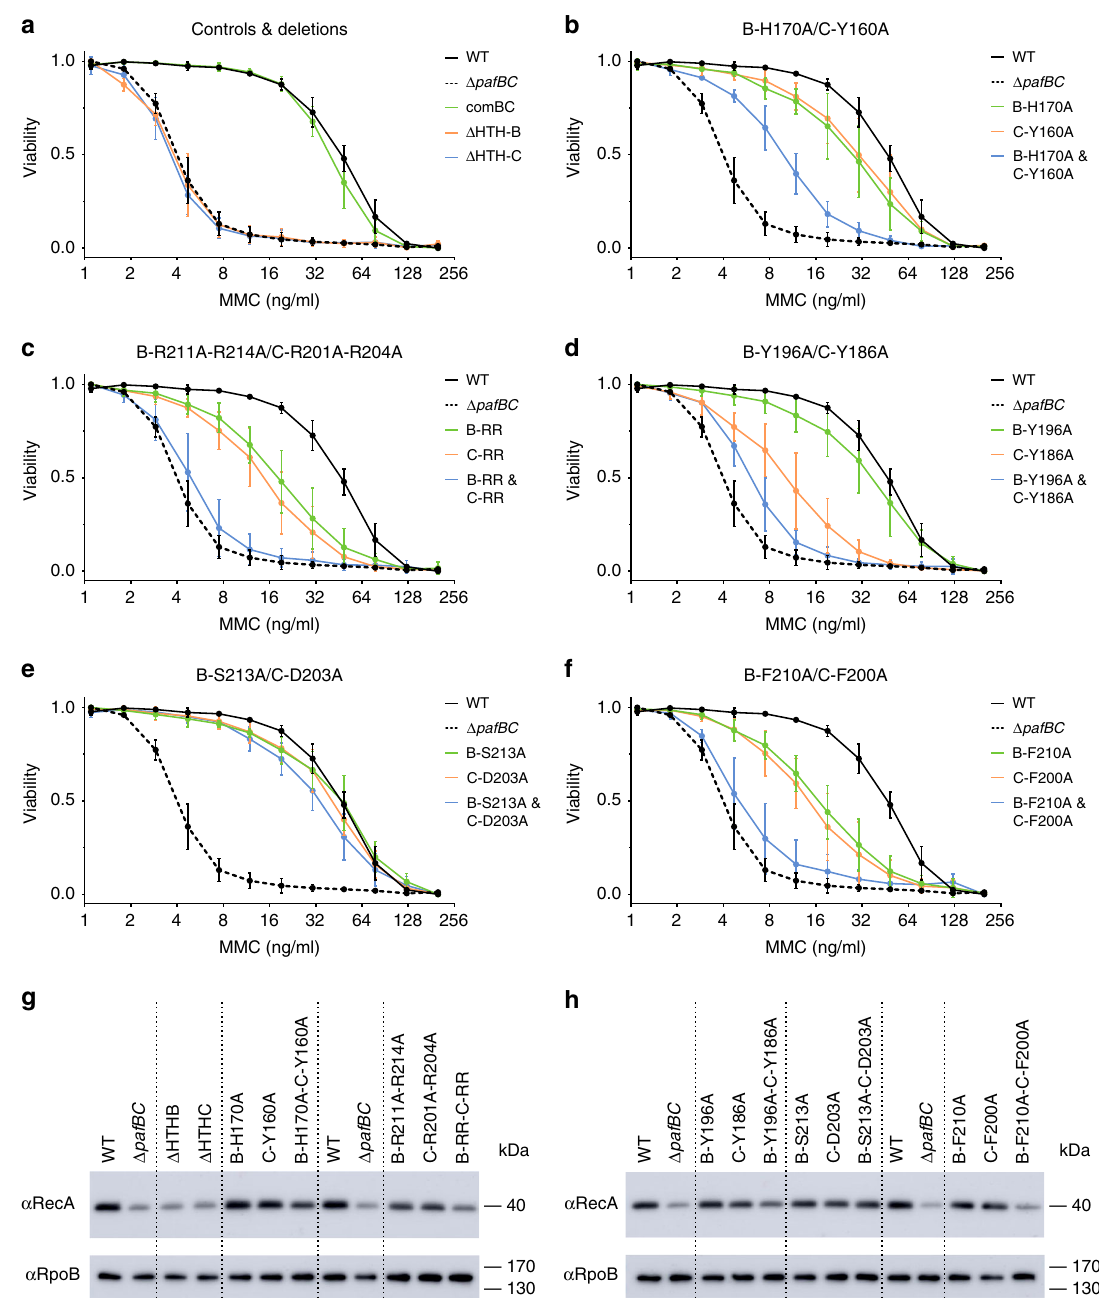
Fig. 5 Mutational complementation screen of residues in the WYL domain of PafBC in Mycobacterium smegmatis . a The M. smegmatis Δ pafBC strain ( Δ pafBC , dashed black line) exhibits a lower viability by an order of magnitude in presence of the DNA-damaging agent mitomycin C (MMC) than the wild type strain (WT, solid black line), which is restored by expressing wild type PafBC (comBC, green). Expression of PafBC with either the HTH domain of PafB or PafC deleted ( Δ HTH-B, orange or Δ HTH-C, blue) results in the same phenotype as observed for the knockout strain. b – f Complementation with alanine substitution mutants in either PafB (green) or PafC (orange) moderately affect viability, while mutations in both proteins (blue) additively reduce the viability, in three cases to knockout levels ( c , d , f ). Each data point represents the mean of three or more individual experiments. Error bars represent the standard deviation of the mean. g – h RecA induction in the complemented strains in response to MMC exposure was compared to the knockout ( Δ pafBC ) and wild type (WT) strains carrying the empty plasmid. Strains were grown to OD600 of 1.0 and exposed to 80 ng/ml MMC for 4 h before immunoblotting for RecA. RpoB served as loading control. See also Supplementary Fig. 8 and Supplementary Fig.